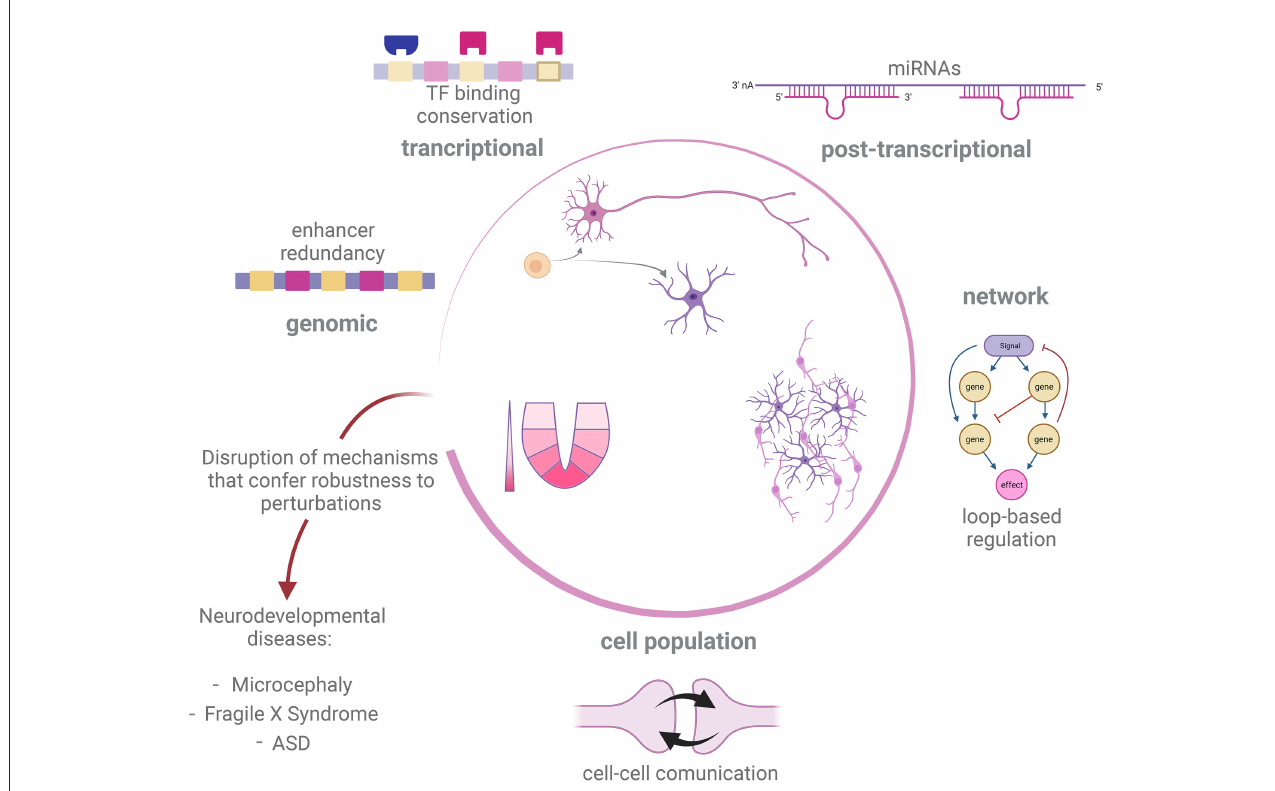
FIGURE2 Robustness mechanism underlying development of nervous system. Development of the nervous system in different metazoan species is tuned by distinct but overlapping regulatory processes, such as sensing of morphogen gradients, cell-cell communication and GRN governing cell fate decisions. In order to correctly deliver such a complex output, different strategies promote robustness against internal or external perturbations at different levels of regulation. Disruption of robustness mechanisms could impair success of some of these developmental processes and therefore trigger neurodevelopmental disease and abnormal conditions, such as microcephaly, Fragile X Syndrome and ASD. Created with